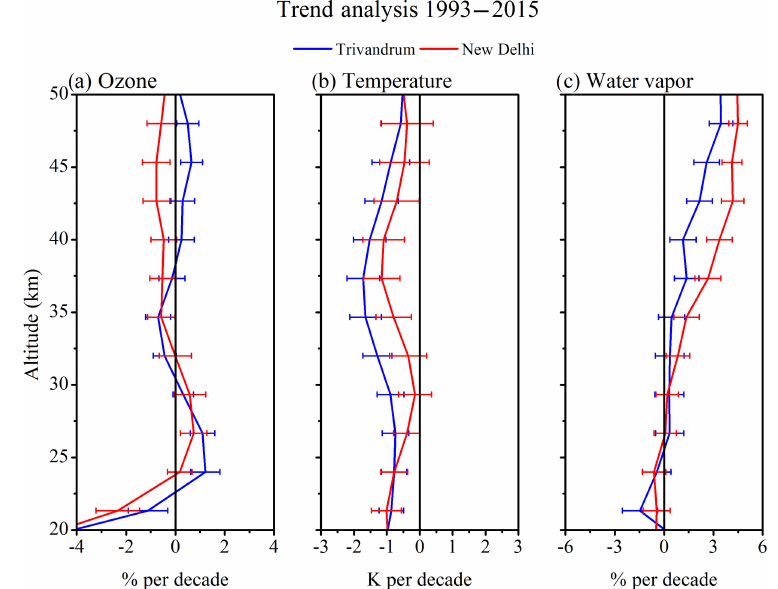
Figure 8. Vertical variation of trend observed in the (a) ozone mixing ratio (in %decade − 1 ), (b) temperature (in Kdecade − 1 ), and (c) water vapor mixing ratio (in %decade − 1 ) obtained from multi-satellite observations over Trivandrum (blue) and New Delhi (red) during 1993–